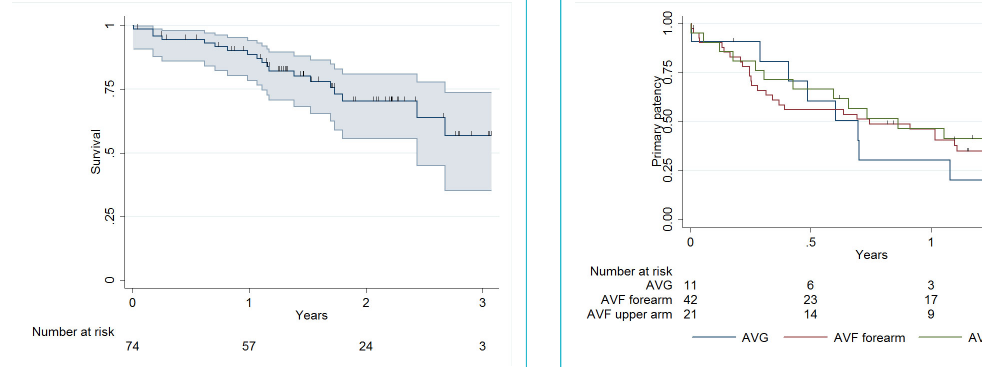
Figure 4: Primary patency of primary vascular access: median pri- mary patency 253.5 days (interquartile range 92–453).AVF = arte- riovenous fistula; AVG = arteriovenous graft